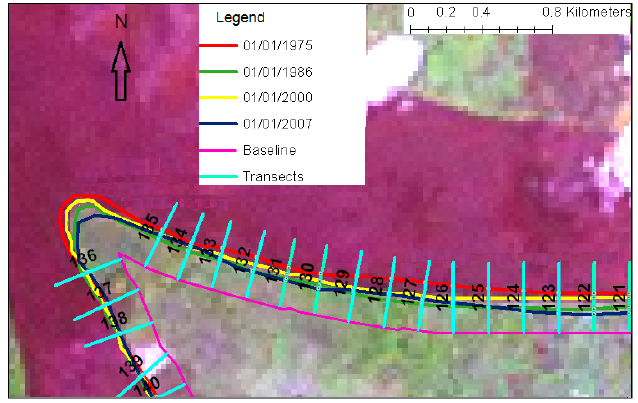
Figure 3. Seaward edge of mangroves showing change 1975 (cid:177) 2007, demonstrating the DSAS technique of measuring change against a measurement baseline, by use of regular perpendicular sample transects.